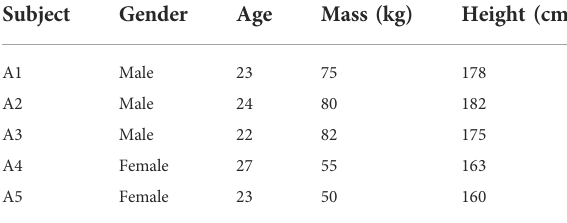
TABLE 1 The physical parameters of each